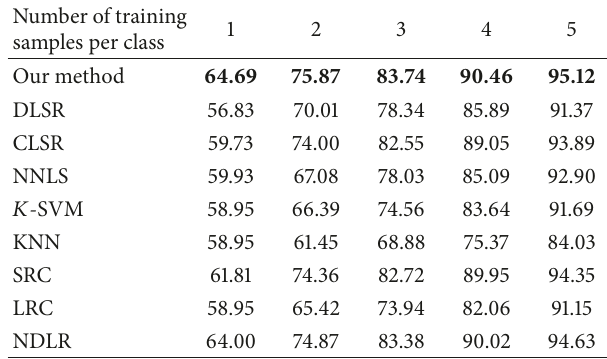
Table 3: Accuracies (%) of different methods on the LFW database. Number of training